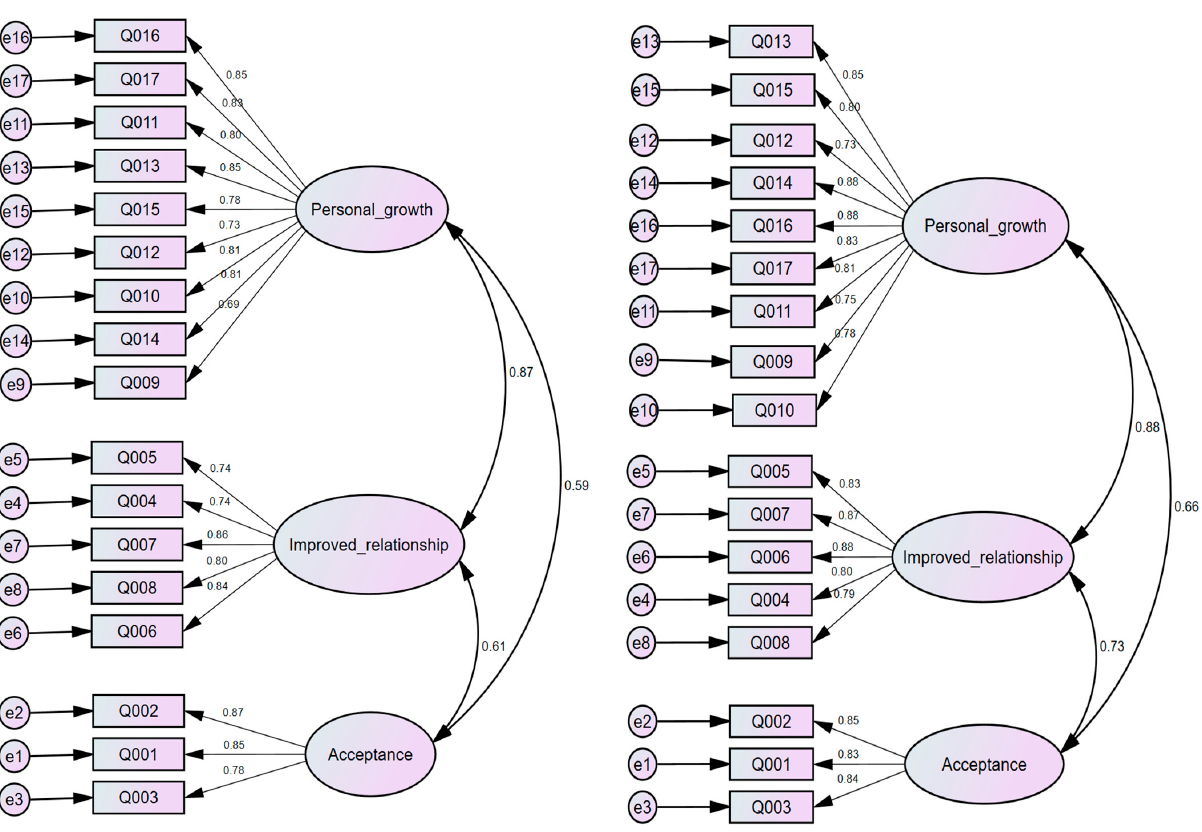
Figure 1. BFS-C structure model with standardized path coefficients for colorectal cancer survivors and spousal caregivers.